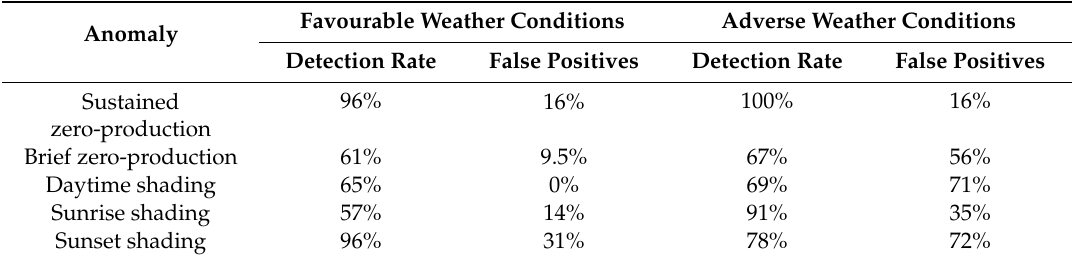
Table 5. Performance of detection algorithms under favourable versus adverse weather conditions.